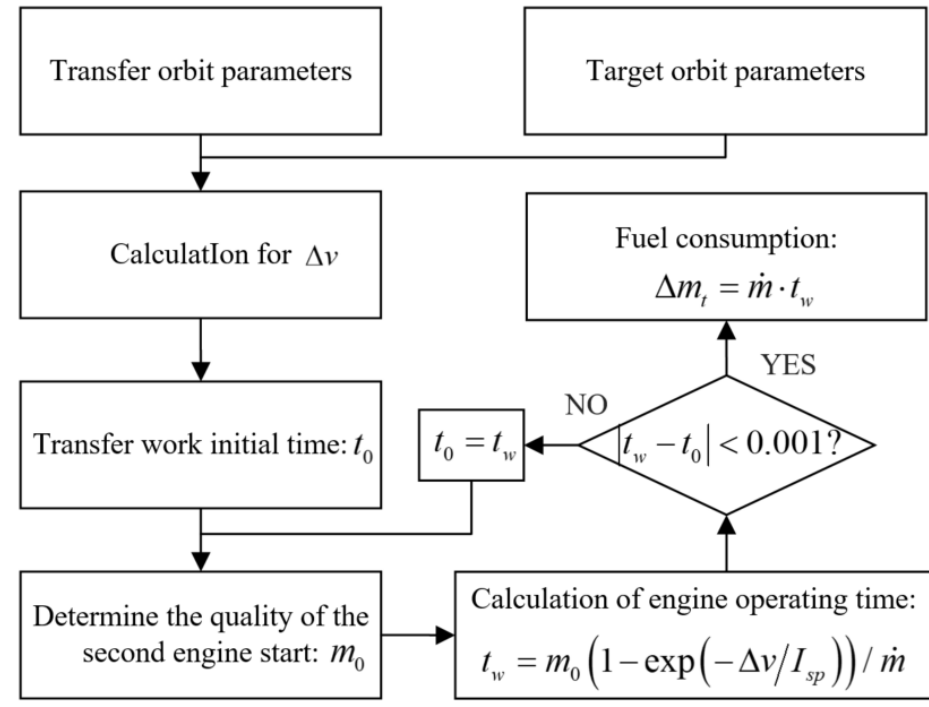
Figure 4. Transfer orbit fuel consumption calculation.